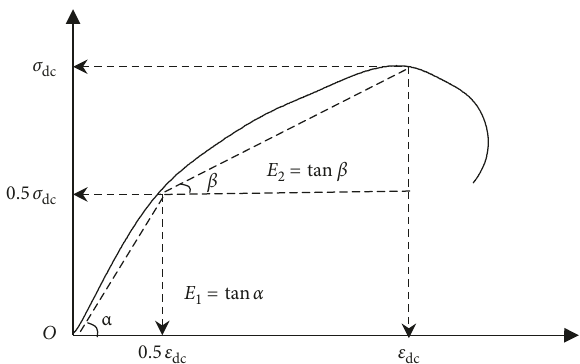
Figure 7: Defining methods of deformation modulus under one- dimensional coupled static and dynamic loads [24].